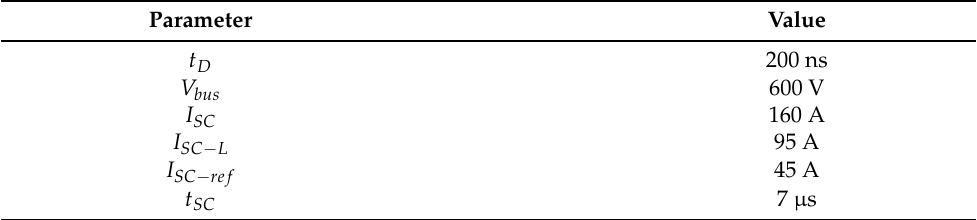
Table 5. Parameters of the studied case study SC condition for FEM simulation.